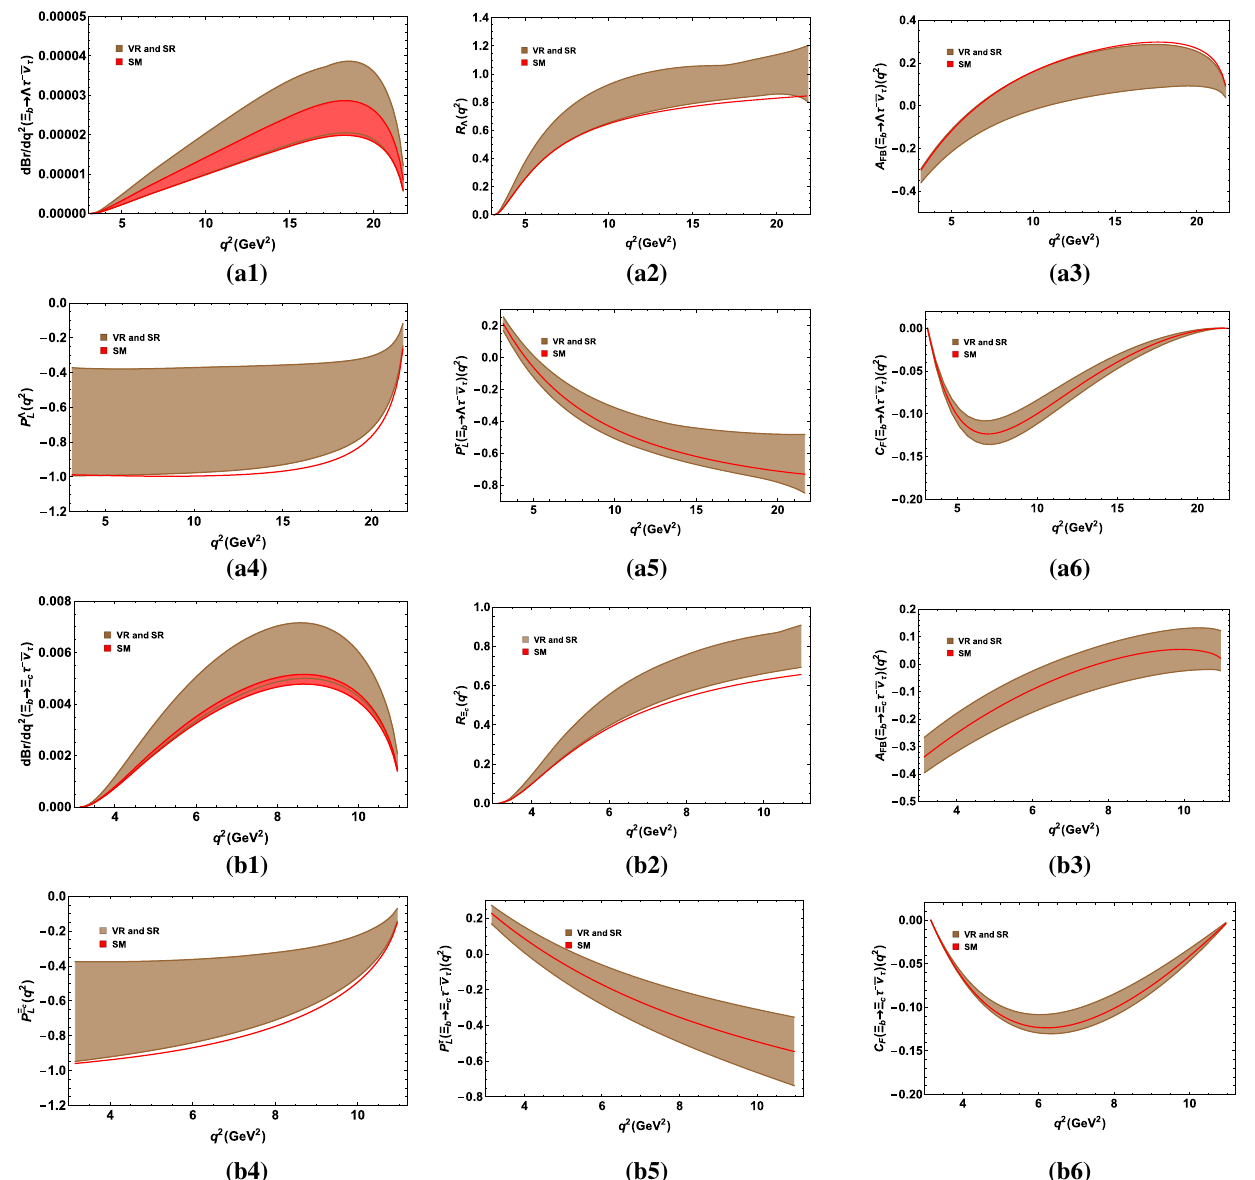
Fig. 8 The SM (red) and NP (brown) predictions in the presence of both V R and S R couplings for the q 2 dependent observables d Br / d q